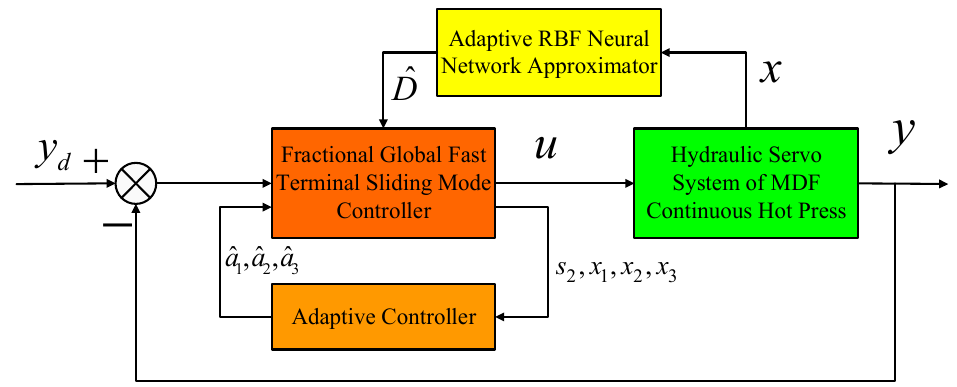
Figure 3. The structure of the FGFTSMC based on adaptive neural network approximator.